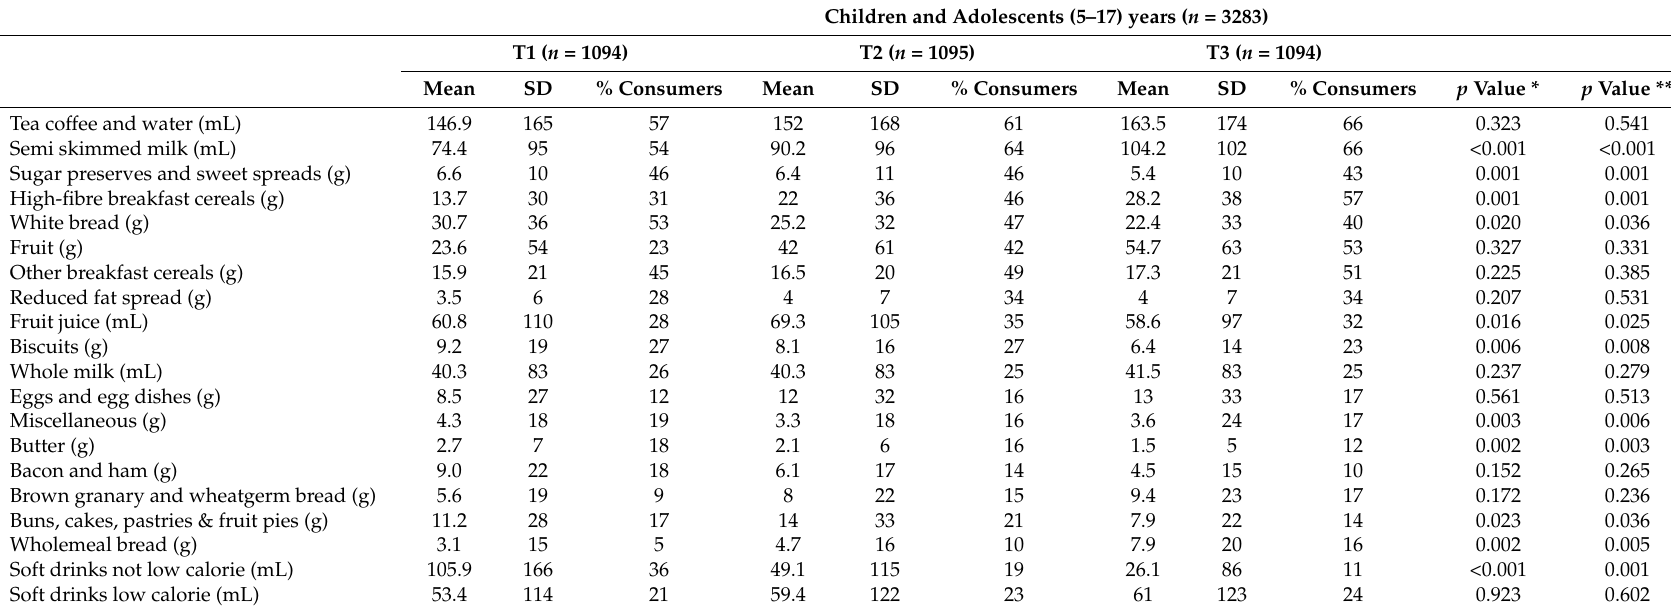
Table 5. Food intakes and % of consumers across tertiles of NRF 9.3 score in children and